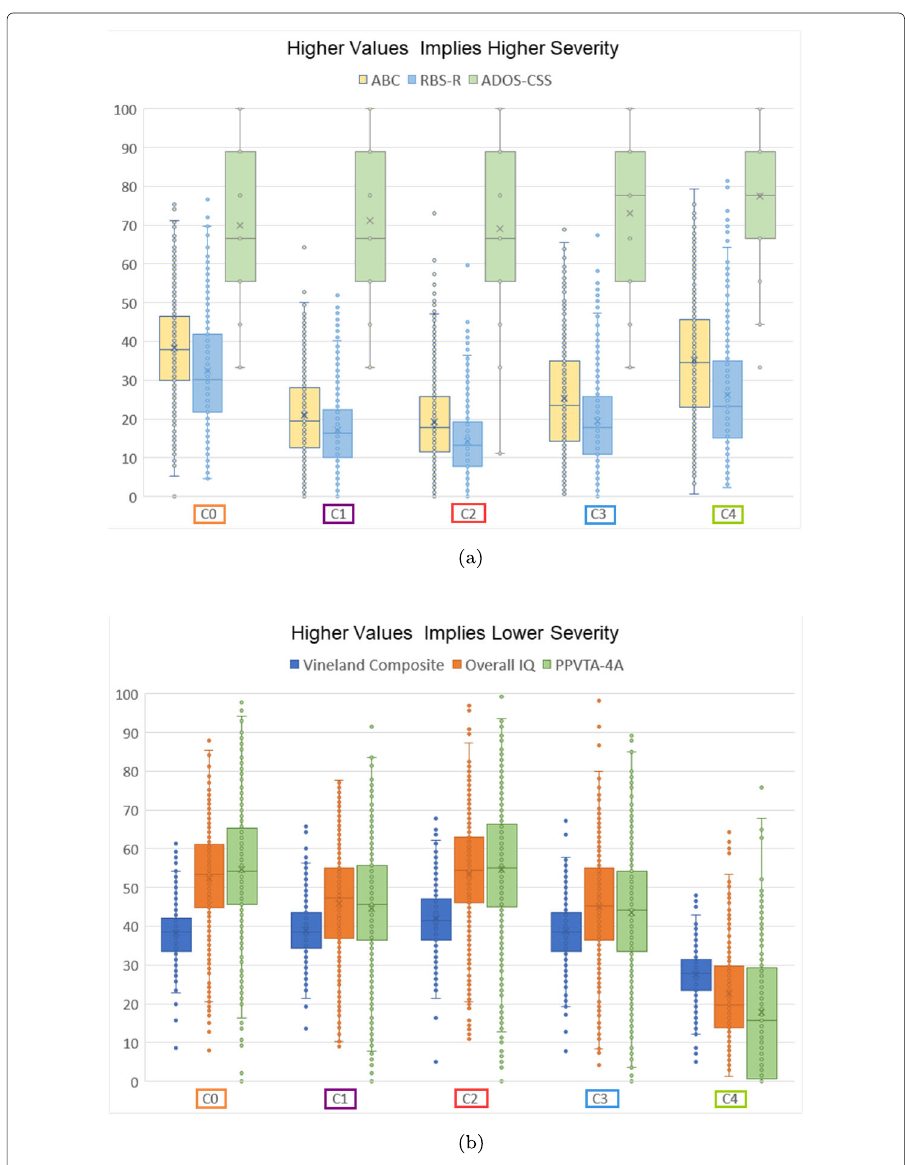
Fig. 4 Analysis of ASD outcome measures (normalized values using known features ranges) across clusters for kNN2 Tenacity 5 clustering configuration. The color of the boxes correlate to the colors of the clusters in Fig. 1e. Gold denotes C0, Purple: C1, Red: C2, Blue: C3, and Green: C4. a Outcome Measures for which values are positively correlated with ASD severity. b Outcome Measures for which values are inversely correlated with ASD severity